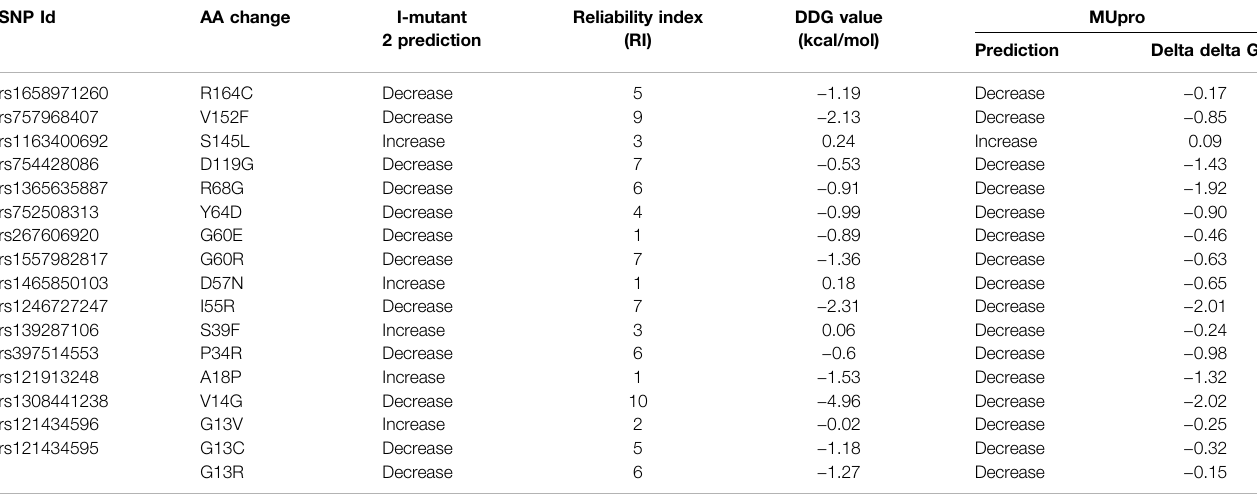
TABLE 2 | Effect of missense variants on NRAS protein stability.